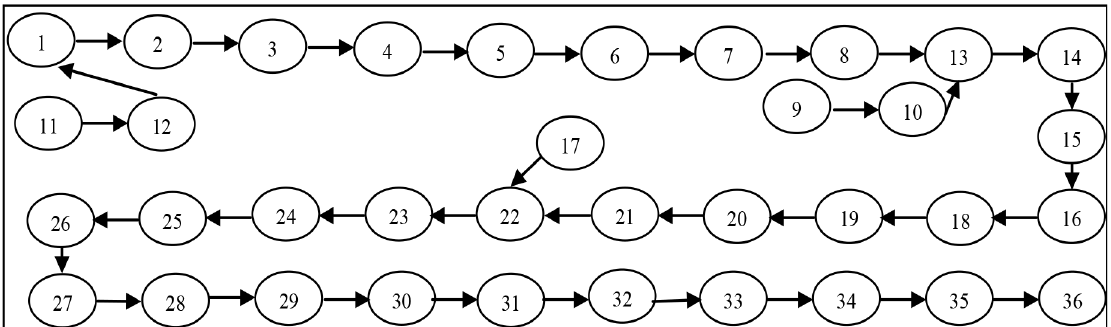
Figure 14. The final precedence